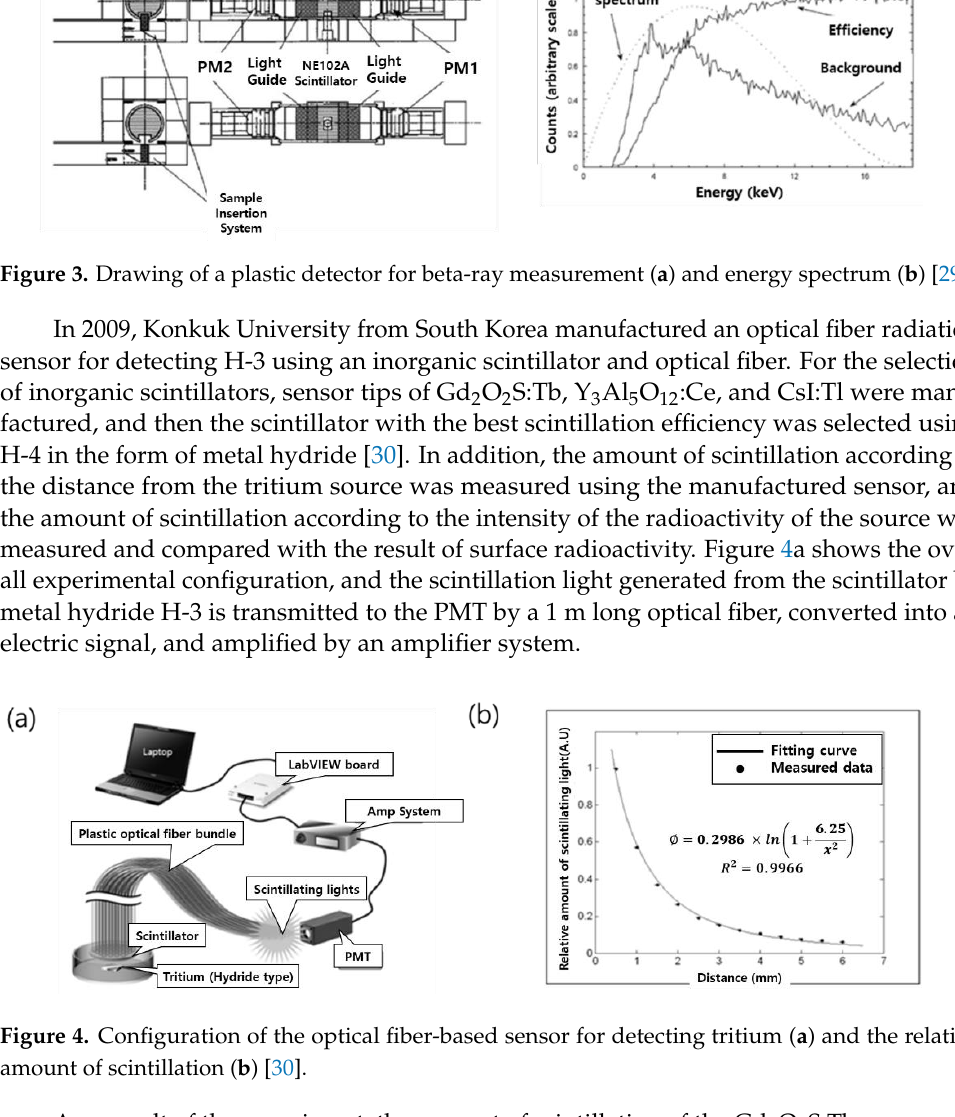
Figure 5. A system designed to measure low-energy beta rays [31]. In 2017, The Korea Atomic Energy Research Institute produced an epoxy-based plas- tic scintillator for beta measurement and optimized the amount of added fluorescent ma- terial. Plastic scintillators were produced by polymerization after adding a fluorescent substance to a benzene-group solvent. The manufacturing process of plastic is shown in Figure 6. In this study, plastic scintillators were manufactured by 2 mm, 4 mm, 6 mm, 8 mm, and 10 mm thickness, as well as performance comparisons by fabricating them while varying the contents of PPO and POPOP. The radiation source was measured by attaching an Sr-90 point source to the plastic surface. The point of this study is that the optimum thickness (4 mm) of the large-size plastic scintillator for beta measurement was derived, and the optimum manufacturing conditions (polymer: PPO: POPOP = 0.79 wt%: 0.2 wt%: 0.01 wt%) were derived [32,33].